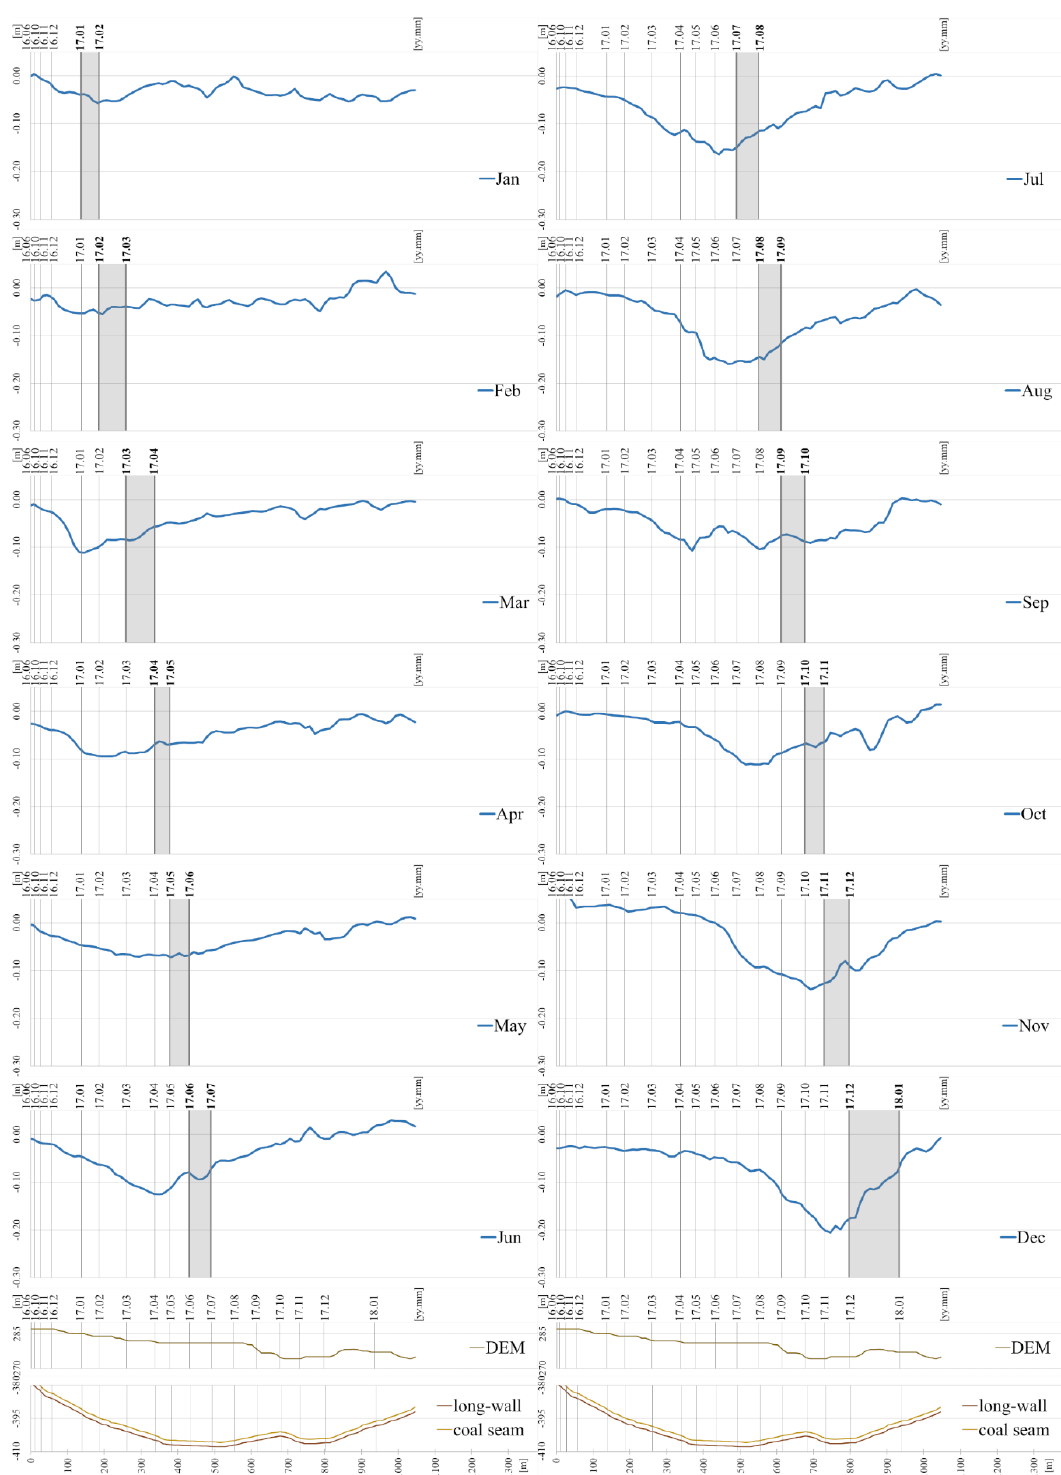
Figure 14. Profile A’A” (longwall No. 6) through the DInSAR: The blue curves show the vertical subsidence by month in 2017. The grey vertical lines show the location of the panels of extractions according to the starting date (above each graph). The shaded area is the currently extracted panel for the presented month. On the bottom of the figure, profiles of the DEM surface and depth and thickness of coal seam are presented.